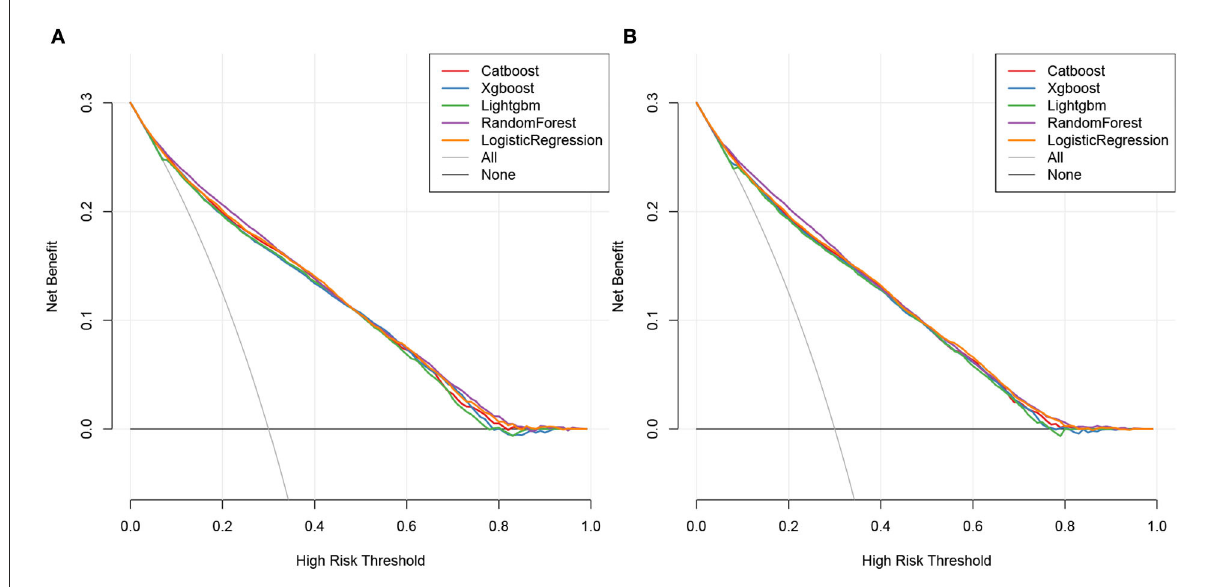
FIGURE8 Decision curve of ML models. Overall early death (A) and cancer-specific early death (B)